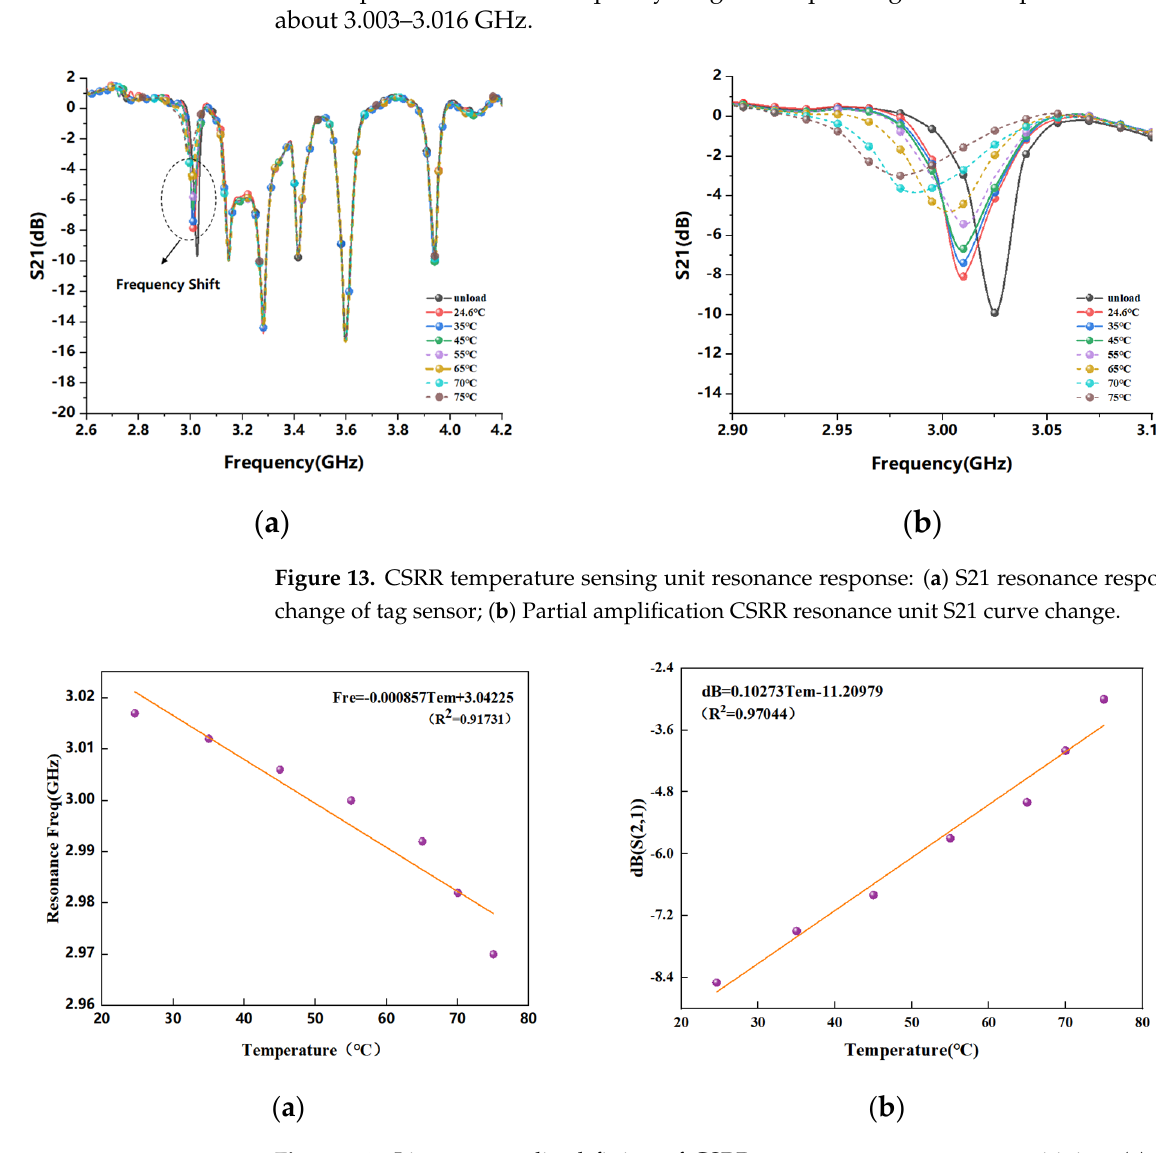
Figure 14. Linear normalized fitting of CSRR resonator temperature sensitivity: ( a ) CSRR res- onant frequency changes with temperature; ( b ) CSRR resonant frequency peak depth changes with